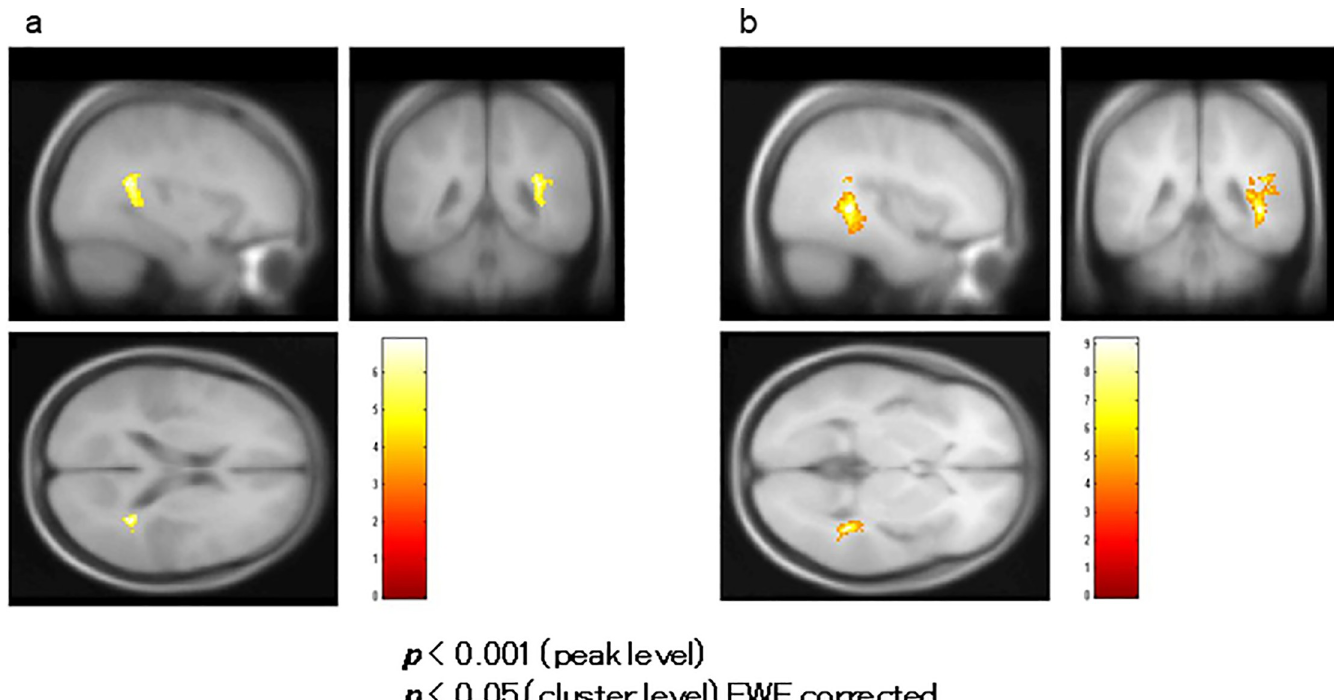
Fig 8. Correlation of functional magnetic resonance imaging (fMRI) with Bell’s PANSS classification. (a) Blood oxygenation level-dependent (BOLD) activity in the right insula and (b) right parahippocampal gyrus significantly correlated with the Positive and Negative Syndrome Scale (PANSS) hostility and positive symptom subtotal scores, respectively, as classified by Bell’s classification. https://doi.org/10.1371/journal.pone.0215023.g008 with connections to the STG and dorsal superior temporal sulcus [69]. The posterior insular cortex is part of the extended auditory cortex and preferentially responds to vocal commuta- tion [70]. The detection of auditory changes in the primary auditory cortex triggers a pre- attentive reorienting response in the right frontal lobe, with feedback to the auditory sensory